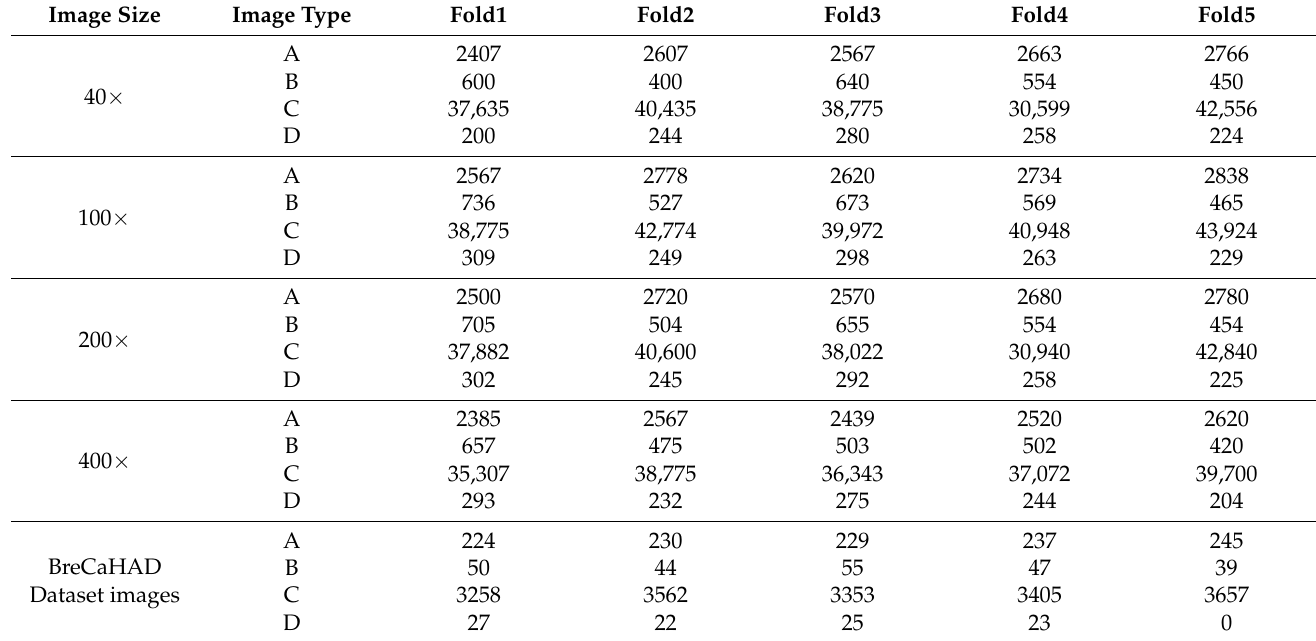
Table 2. The Images from Both Datasets, where A: Training Images, B: Testing Images, C: Augmenta- tion, and D: Validation.